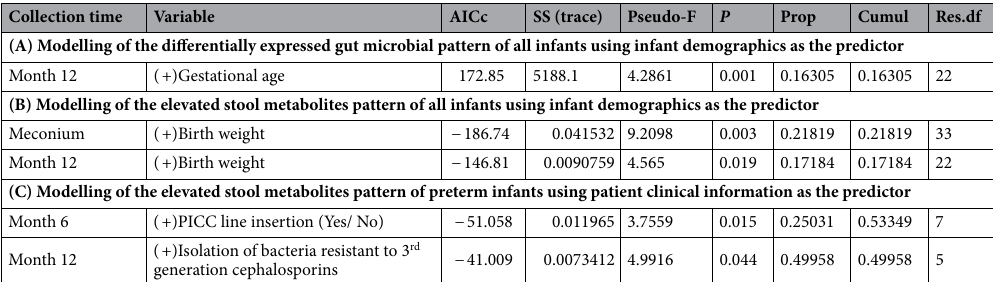
Table 4. Cross-modelling of the stool microbial and metabolites profiles using a stepwise selection procedure. Prop. = explanatory proportion, Cumul. = cumulative explanatory proportion, Res.df = residual degree of freedom, ( +) = inclusion, PICC = Peripherally inserted central catheter. Only elements with significant effect are